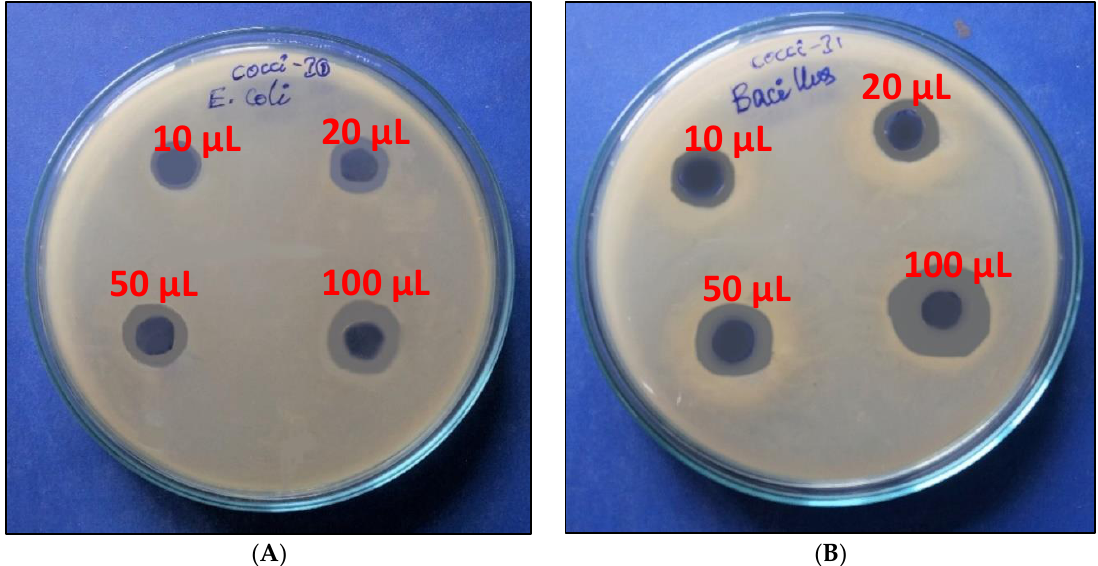
Figure 4. Antibacterial activity of culture-free supernatant E. coli and Bacillus subtilis ( A , B ) of Pedio- coccus pentosaceus HLV1.